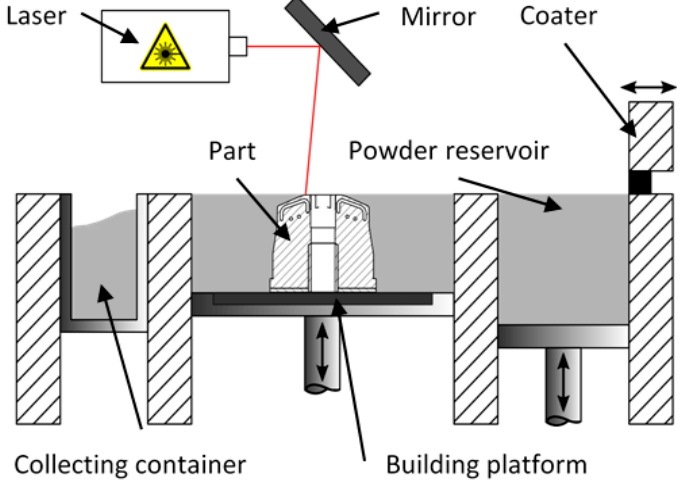
Figure 2. The Powder Bed Fusion (PBF) process.